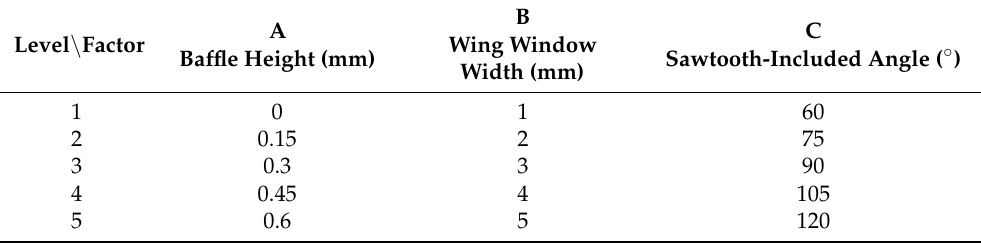
Table 4. Horizontal factor relationship